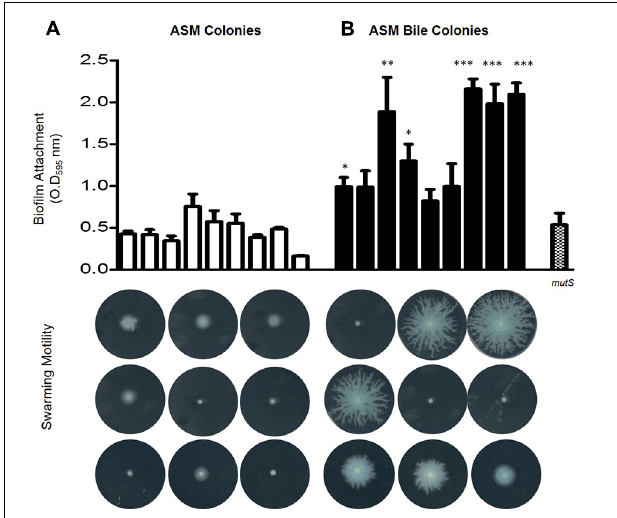
FIGURE 2 | Phenotypic analysis encompassing biofilm formation and swarming motility in 9 colonies from three independent biological replicates isolated from (A) untreated ASM and (B) bile treated ASM. Data is the mean of at least three independent biological replicates. Statistical analysis was performed by Student’s t -test ( ∗ p ≤ 0.05; ∗∗ p ≤ 0.01; ∗∗∗ p ≤